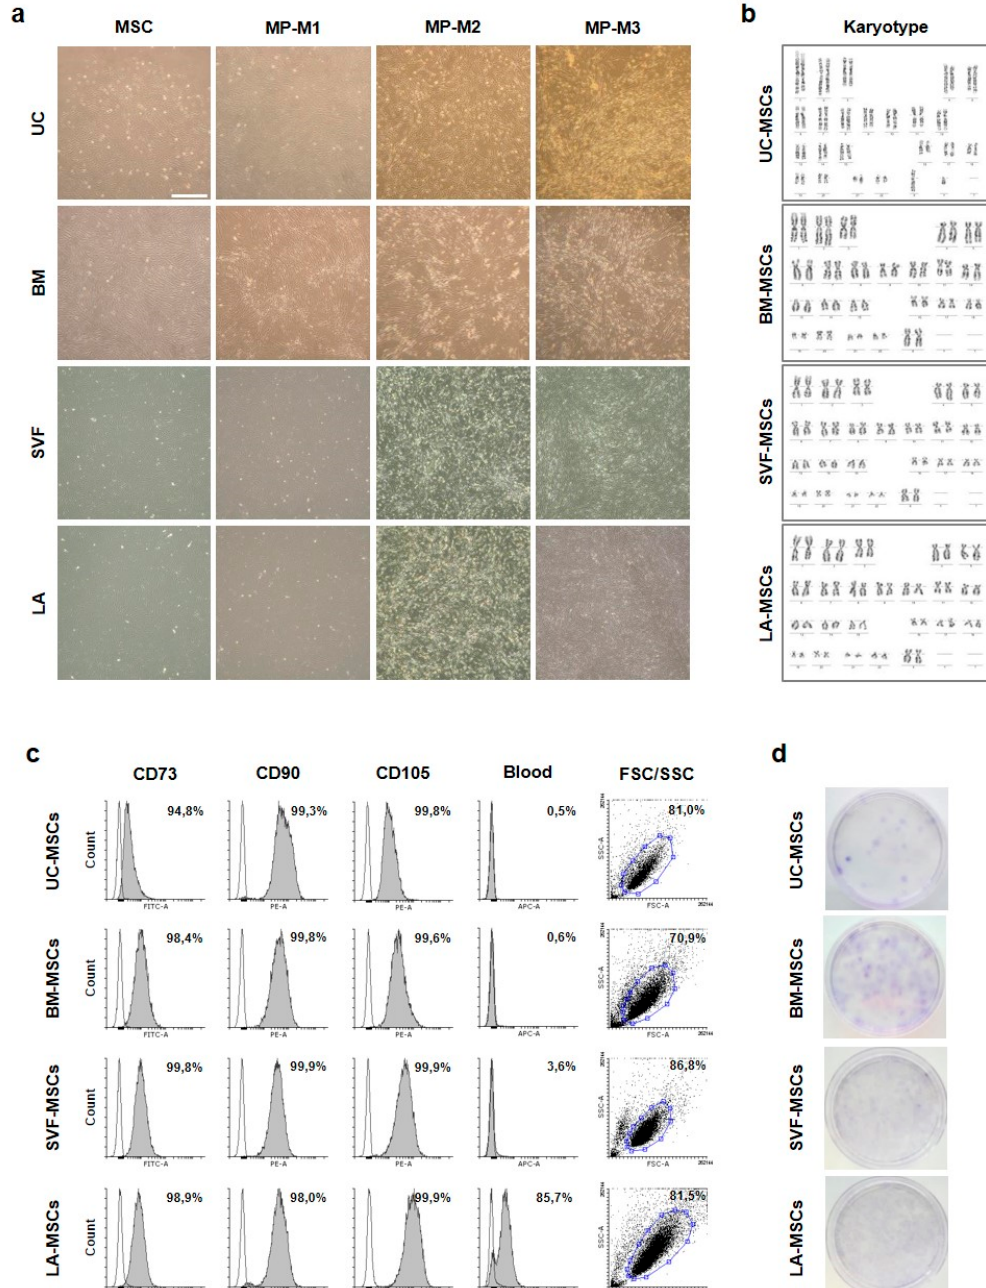
Figure 2. Characterization of tissue-specific MSCs. ( a ) Morphology (phase-contrast image) of adherent cells during MSC derivation and MPs after three passages in M1, M2 and M3 media. Scale bar, 1mm. ( b ) Derived MSCs have normal karyotype. Chromosome numbers were counted in at least 40 spreads and at least 10 of them were fully differentiated at 450–500 G-band level. ( c ) Flow cytometry results for MSC markers. MSCs were positive for CD73, CD90 and CD105 and negative for blood markers. The grey area represents the marker expression, the grey line depicts isotype control expression, the percentage of marker positive cells is given. FSC/SSC dot plot denotes the gated population. ( d ) CFU-F ability of MSCs seeded at the density of 50 cells per square centimeter. Giemsa staining shows variable number and potency of MSC progenitors.